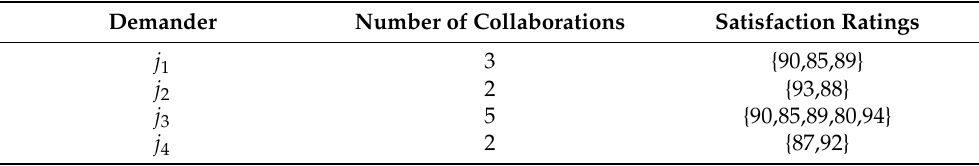
Table 2. Number of times demanders have worked with i 1 and satisfaction ratings. Demander